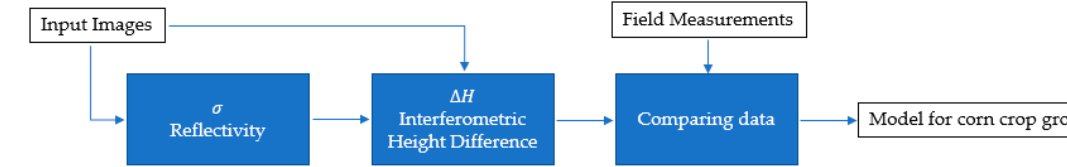
Figure 5. Block diagram for the estimation model for corn crop growth.